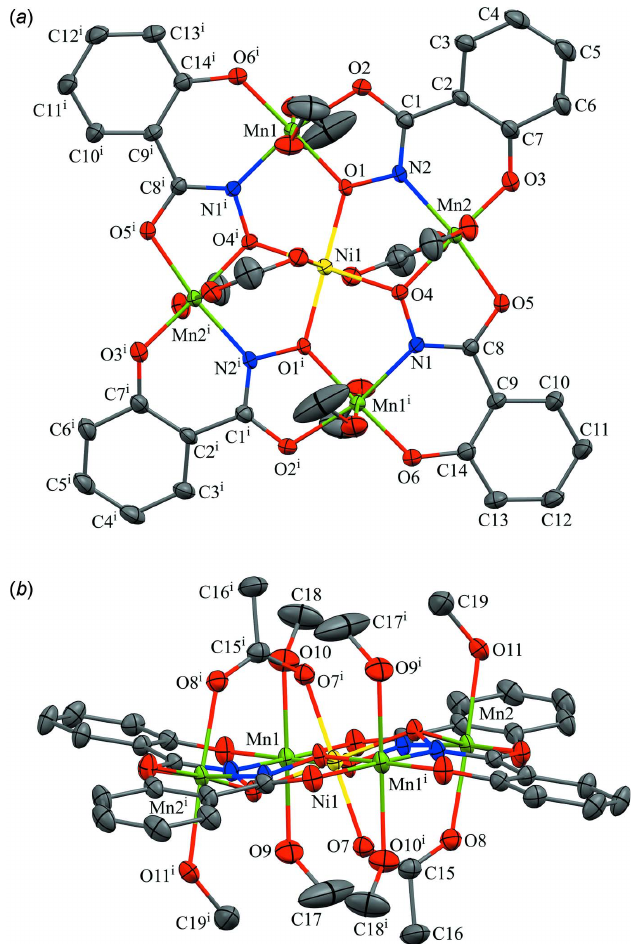
Figure 1 The molecular structure of the title compound, ( a ) top view with only the metal atoms and shi 3 (cid:3) ligands labeled for clarity and ( b ) side view with only the metal atoms and axial ligands labeled for clarity. The displacement ellipsoids are at the 50% probability level. For clarity, hydrogen atoms and solvent molecules have been omitted. [Color scheme: yellow–Ni II , green–Mn III , red–O, blue–N and gray–C; symmetry code: (i) (cid:3) x + 1, (cid:3) y + 1, (cid:3) z +